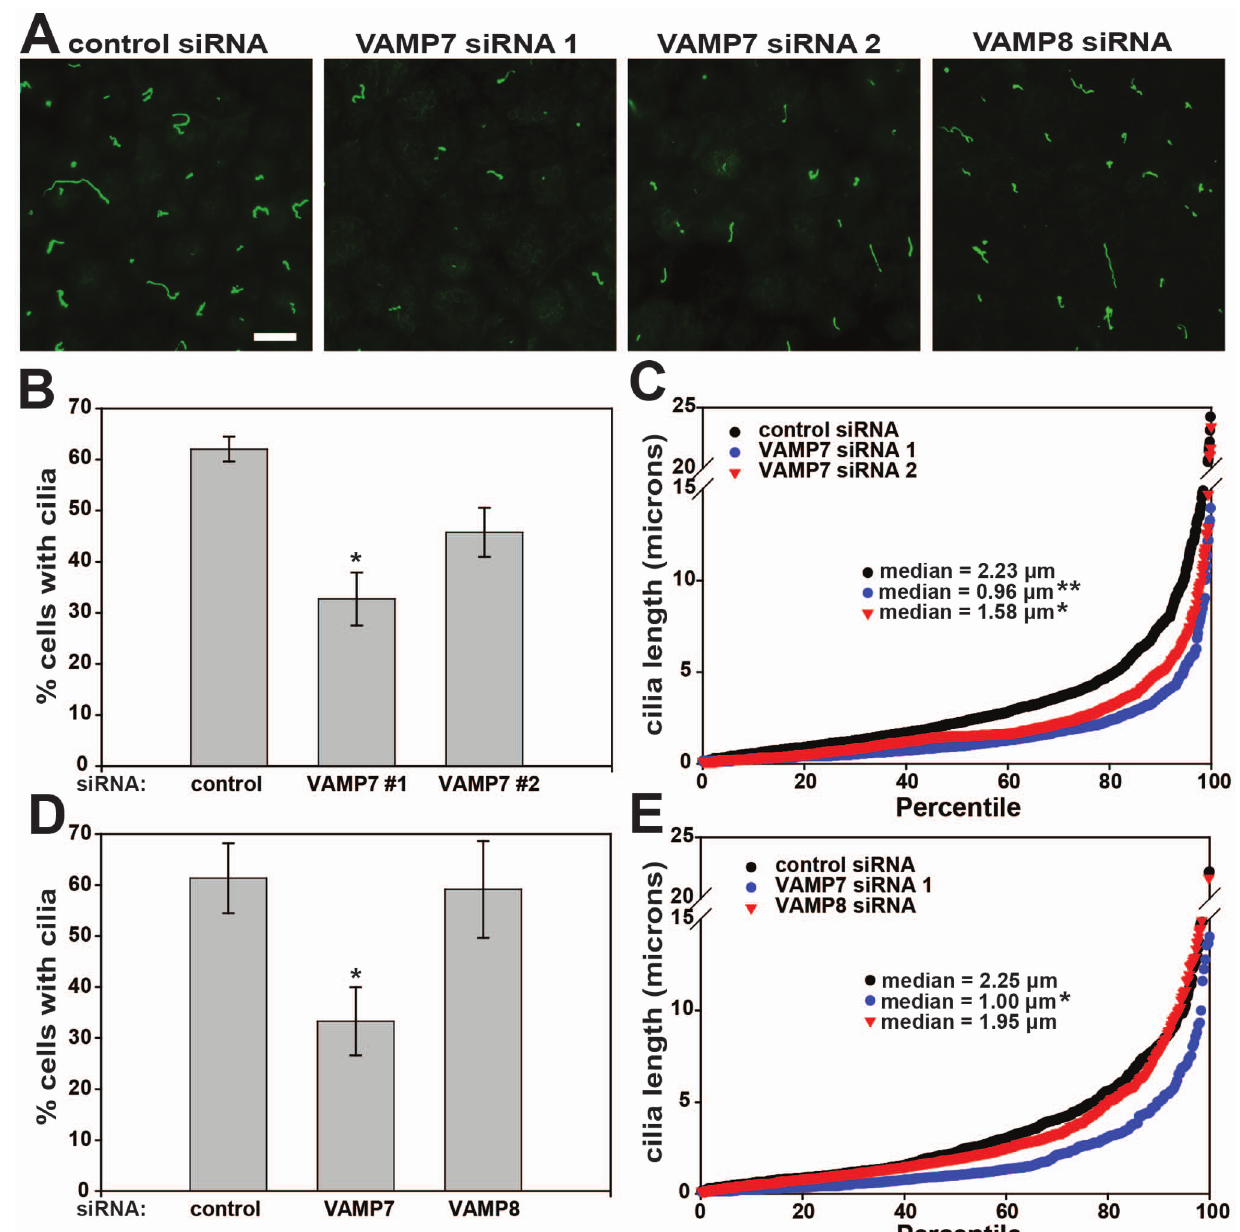
Figure 4. VAMP7 knockdown decreases cilia frequency and cilia length in MDCK cells. (A) MDCK 2001 cells were transfected as indicated with control siRNA, our standard VAMP7 siRNA (VAMP7 # 1), a less effective VAMP7 targeting sequence (VAMP7 # 2), or VAMP8 siRNA. Cells were cultured for four days on permeable supports, then fixed and processed for indirect immunofluorescence to detect acetylated tubulin and cell nuclei. Representative fields acquired using epifluorescence microscopy are shown. Scale bar=10 m m. (B, D) The number of cells in multiple fields was determined using DAPI nuclear stain and used to quantify the fraction of cells with a primary cilium in each sample. The average of three experiments is plotted (mean + / 2 SEM); *p , 0.05 compared to control using one-way ANOVA with Bonferroni correction. (B) Control n=1,907; VAMP7 n=1,747; VAMP7 # 2 n=1,608 cells. (D) Control n=1,040, VAMP7 n=1,169, VAMP8 n=1,049 cells. (C, E) Cilia lengths in multiple fields were measured using ImageJ software, then sorted by length in ascending order and graphed by percentile (100 th percentile=longest cilium in each sample). Each point on the graph represents the length of an individual cilium. (C) There was a statistically significant reduction in cilia length in cells transfected with VAMP7 # 1 and VAMP7 # 2 siRNAs, as assessed by comparing the medians from four experiments (*p , 0.05, **p , 0.01 using one-way ANOVA with Bonferroni correction). (E) There was a statistically significant reduction in cilia length in VAMP7 depleted cells, as assessed by comparing the medians from three experiments (*p , 0.05 using one-way ANOVA with Bonferroni